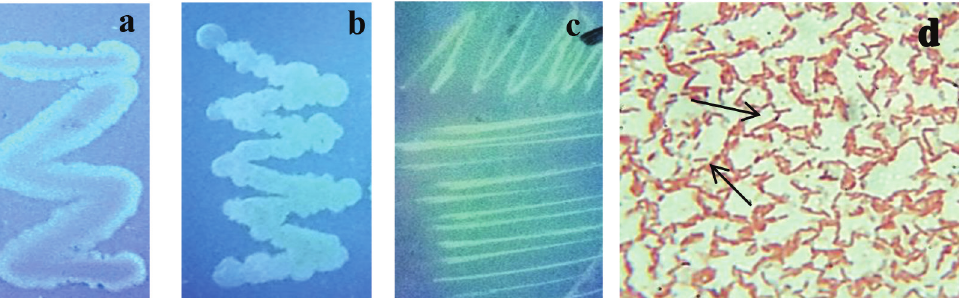
Figure 2: PHA production in live cells and under light microscope. (a,b) Screening on Nile blue containing PHA detection media demonstrates blue fluorescence under UV light by Bacillus subtilis and Bacillus tequilensis respectively. (c) Screening on Nile red containing PHA detection media demonstrates green fluorescence under UV light by Pseudomonas aeruginosa . (d) Sudan Black B staining micrograph of Bacillus subtilis shows presence of PHA granules (as indicated by arrows).